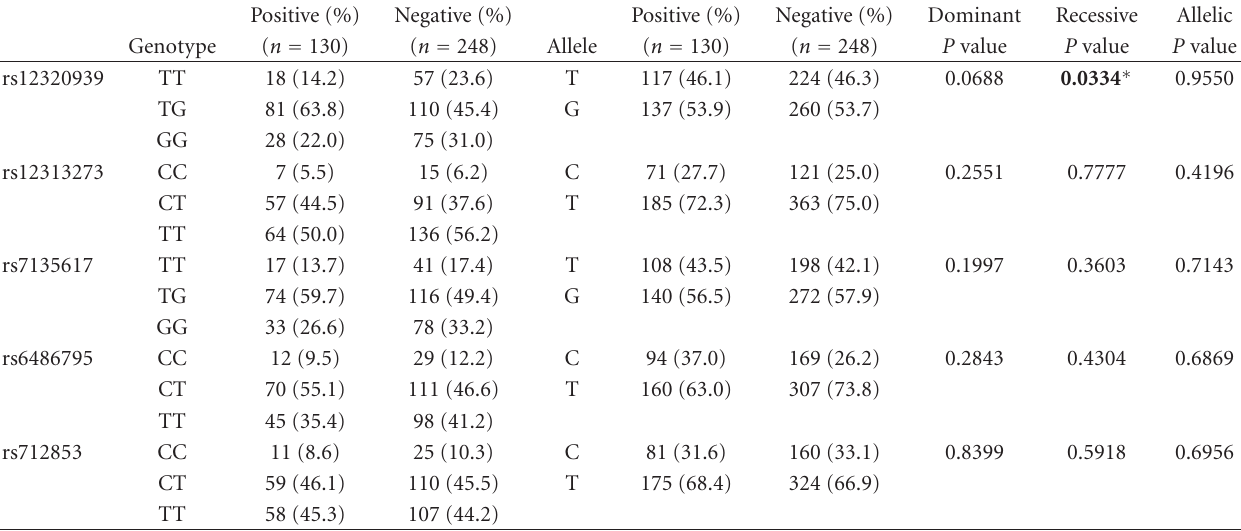
Table 2: Genotyping and allele frequency of ORAI1 gene in patients with breast cancer with or without nodal